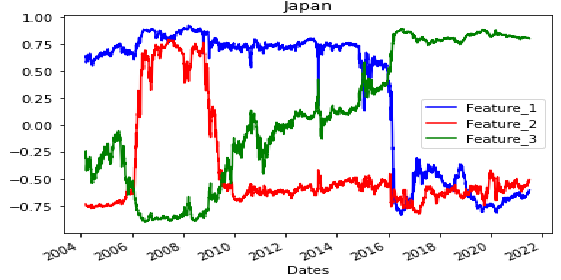
Figure 14. Japan AE prediction